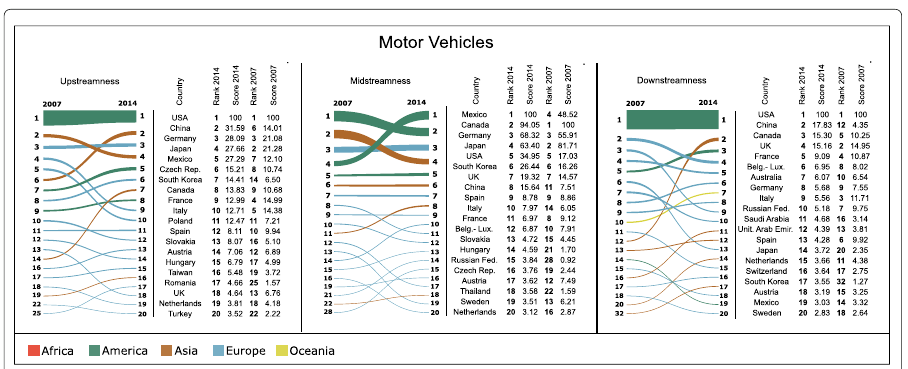
Fig. 3 Bump charts showing the variation in rankings and values of upstreamness ( left-handcolumn ), midstreamness ( centrecolumn ), and downstreamness ( right-handcolumn ) centralities of countries in the Motor Vehicles industry between 2007 and 2014. Each line in the bump charts shows the variation of ranking for each country, and the width of each line at the two endpoints is proportional to the centrality score in the corresponding year. Only the 20 top-ranked countries in 2014 have been included. The scores underlying the two rankings in each bump chart have been normalised so as to produce equal sums of widths of endpoints at each year. Beside each bump chart is a table illustrating the rankings and centrality scores normalised according to Eqs. 5, 7, and 9. The colour of each line in the bump charts refers to the geographic continent of the corresponding country. Bump charts were obtained using